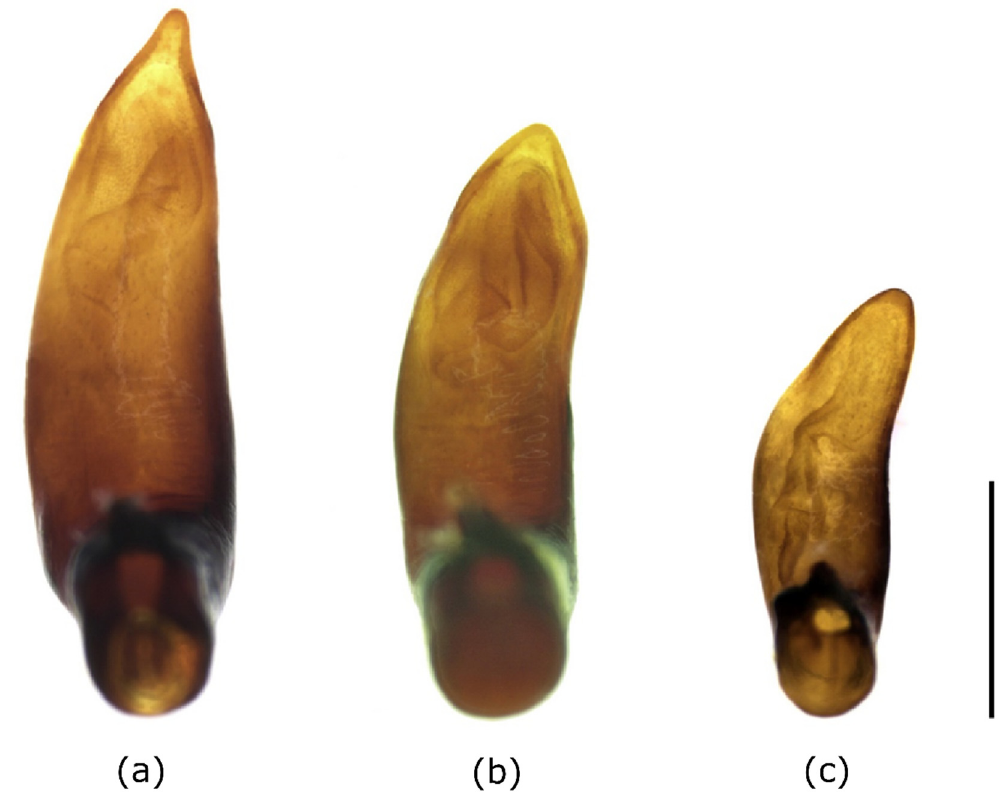
Figure 3. Comparison of the aedeagi of Pterostichus adstrictus , Kaunertal/Austria ( a ), P. oblongopunctatus , Rabachboden/Austria ( b ) and P. quadrifoveolatus , Lopenik/Czech Republic ( c ), median lobe in ventral view, scale bar = 1 mm.